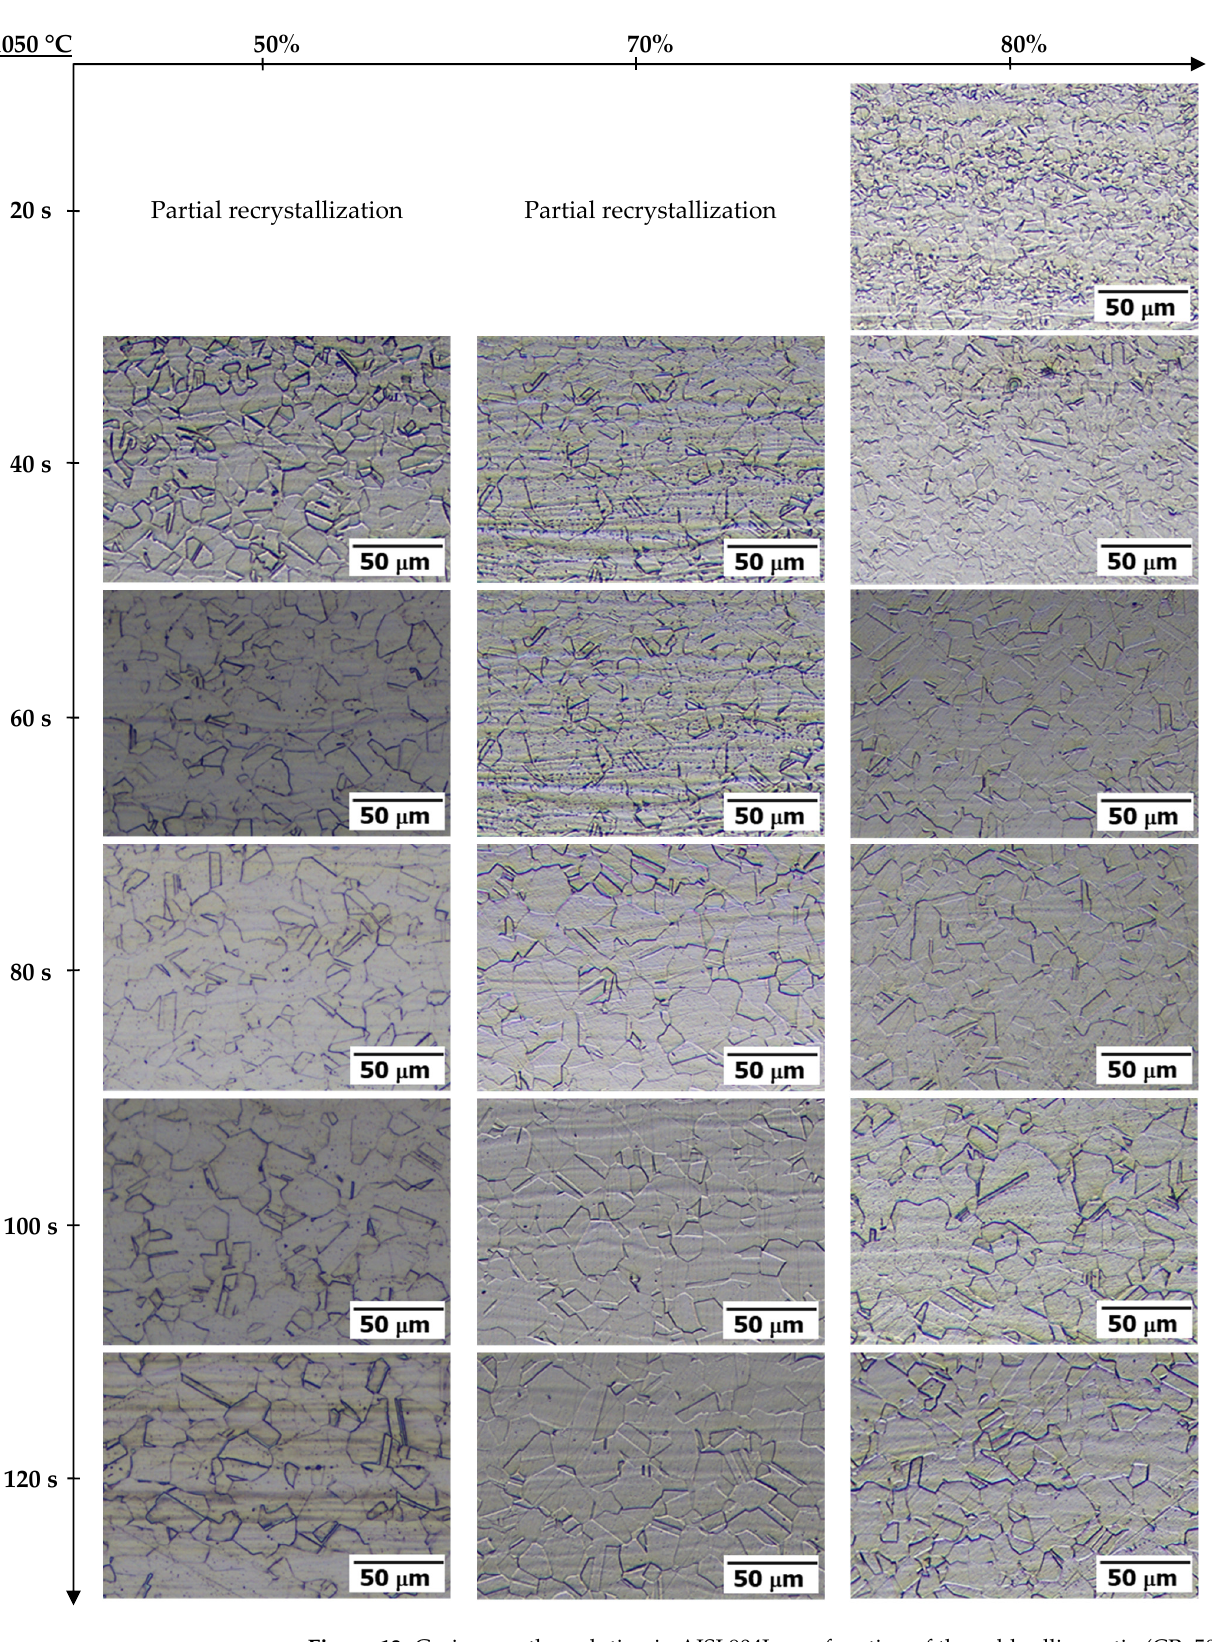
Figure 13. Grain growth evolution in AISI 904L as a function of the cold rolling ratio (CR: 50%, 70%, 80%) after annealing treatment at 1050 °C and soaking times in the range of 20–120 s.